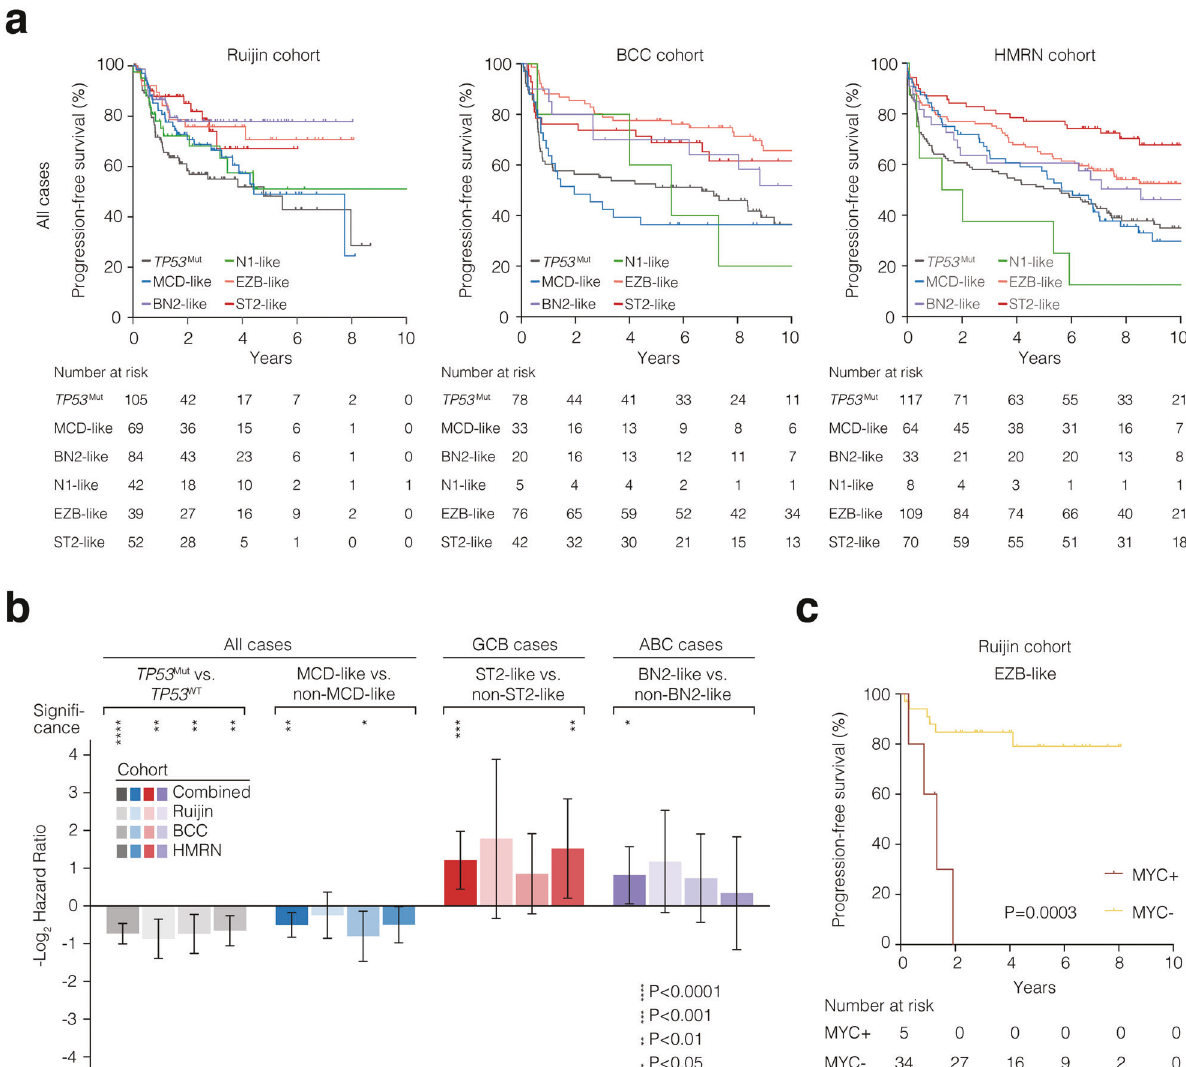
Fig. 4 Prognostic attributes of DLBCL genetic subtypes. a Kaplan – Meier plots for PFS in all cases of the indicated DLBCL cohorts. b Hazard ratios (-log2 transformed) for the comparisons between genetic subtypes in the indicated DLBCL cohorts. c Kaplan – Meier plots for PFS in the EZB-like cases of the Ruijin